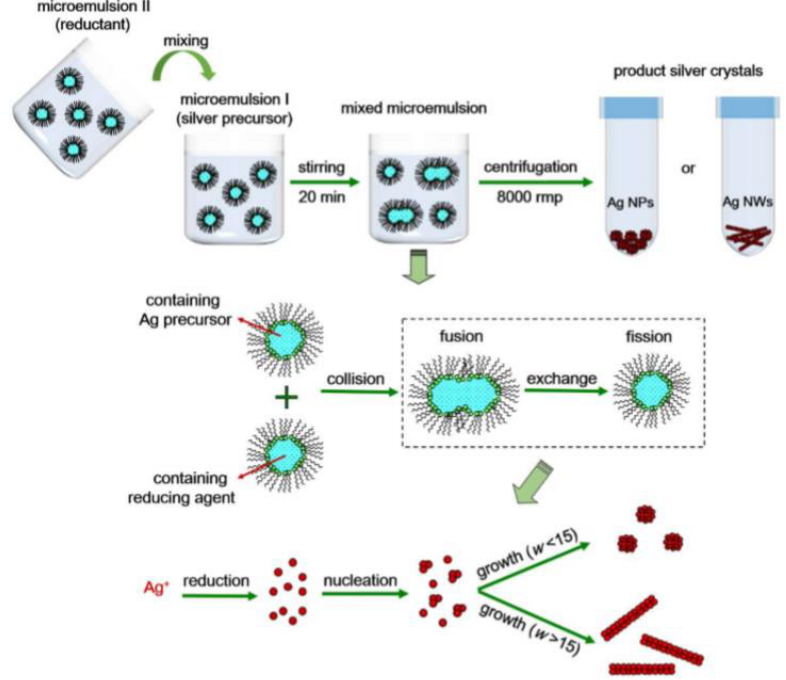
Figure 1. Schematic of the reaction process with a reverse micro emulsion method.